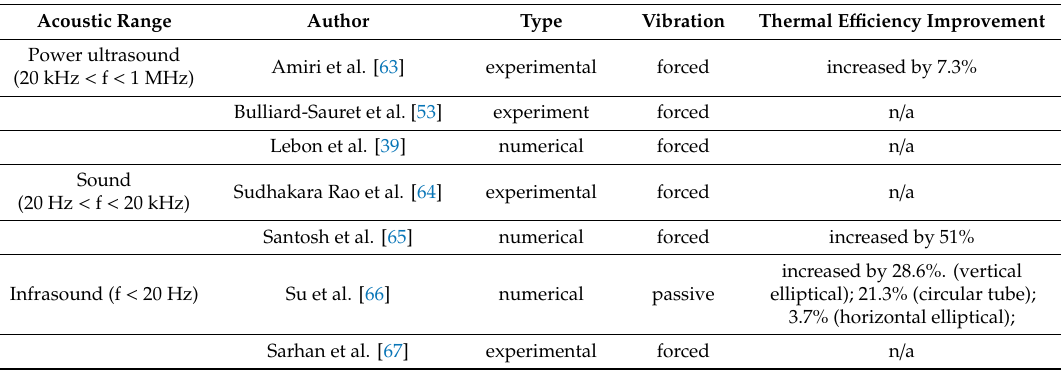
Table 3. Current research on heat-transfer enhancement using vibration at various acoustic range. Acoustic